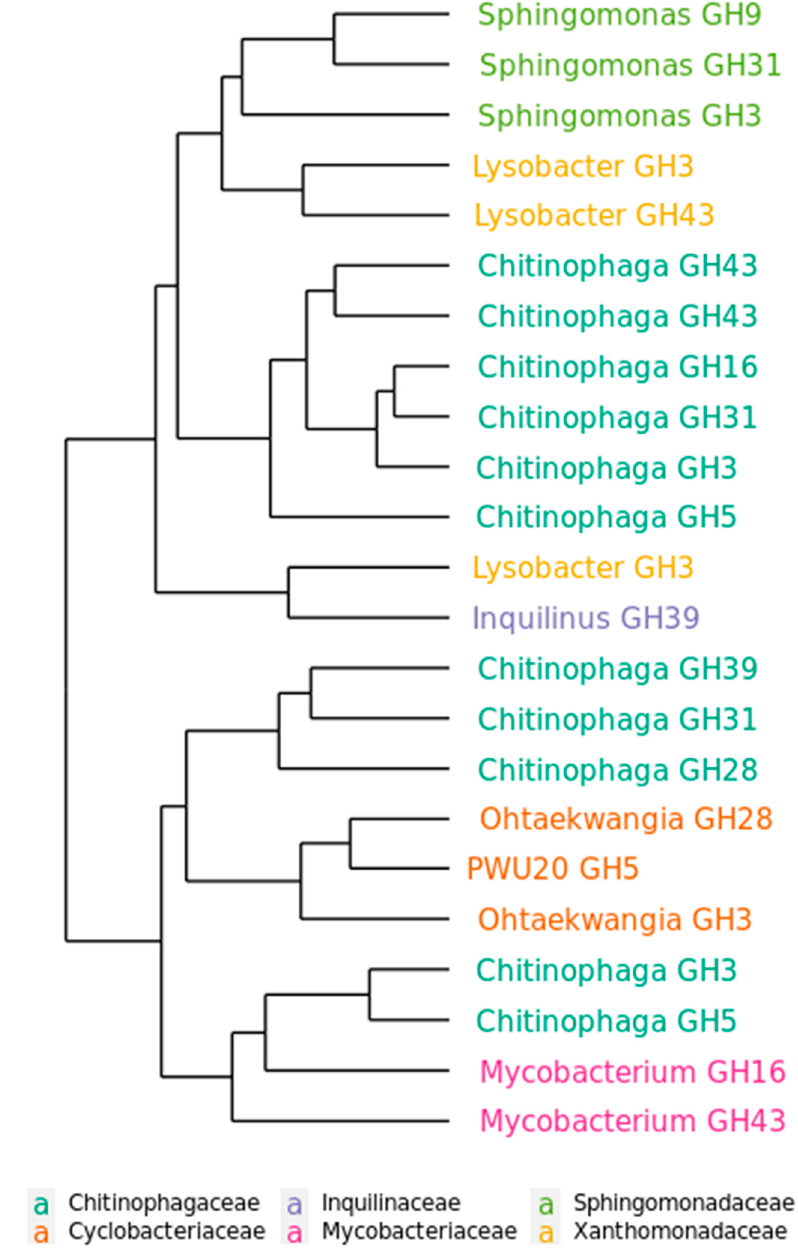
Figure 6. The WPGMA clusterization of the dynamics of selected GH genes across three decomposi- tion phases accessed by the real-time analysis. Each node represents real-time data for one of the GH genes used in the analysis. The name of the node includes taxonomic (on the genus level) and GH family attribution of the gene. The color of the node name represents taxonomic attribution on the family level.